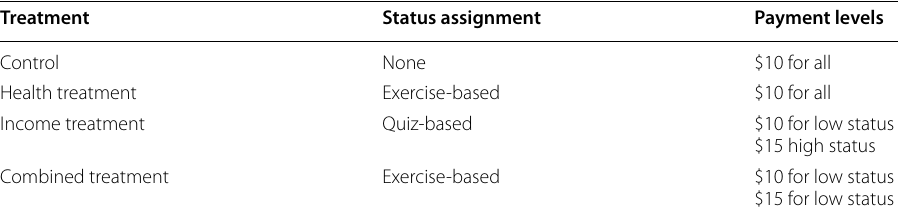
Table 1 Experimental treatments and payment levels